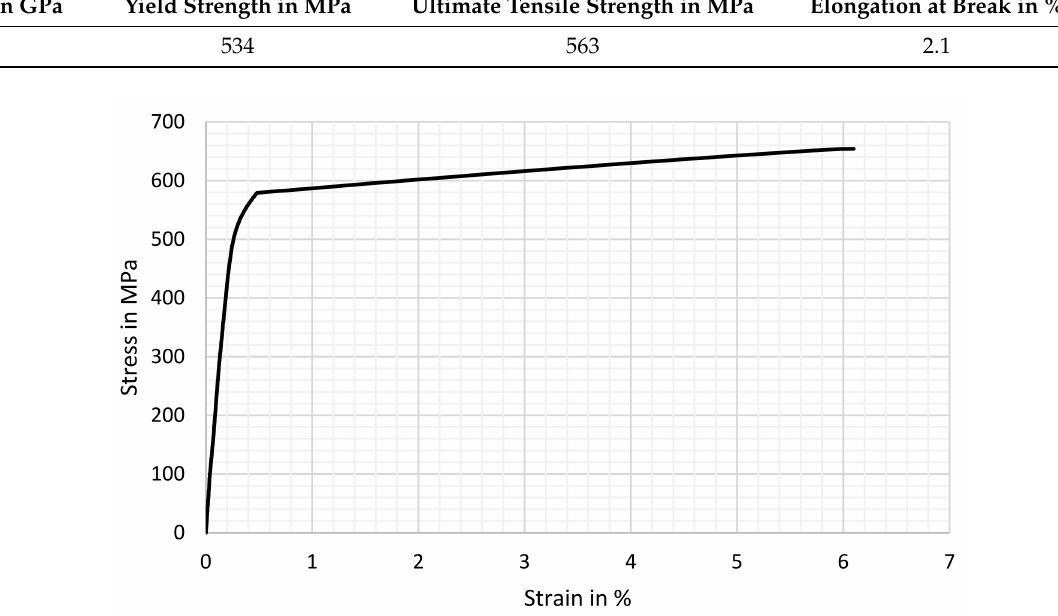
Figure 6. Stress–Strain curve in tensile test